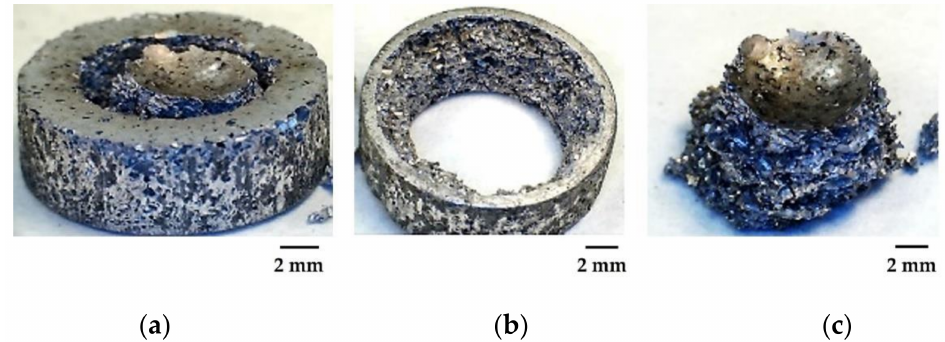
Figure 12. Al foam after impact test. ( a ) Sample directly extracted from the column impact machine. ( b ) Detail of foam portion that did not suffer the indenter impact directly. ( c ) Detail of foam portion that suffered the indenter impact